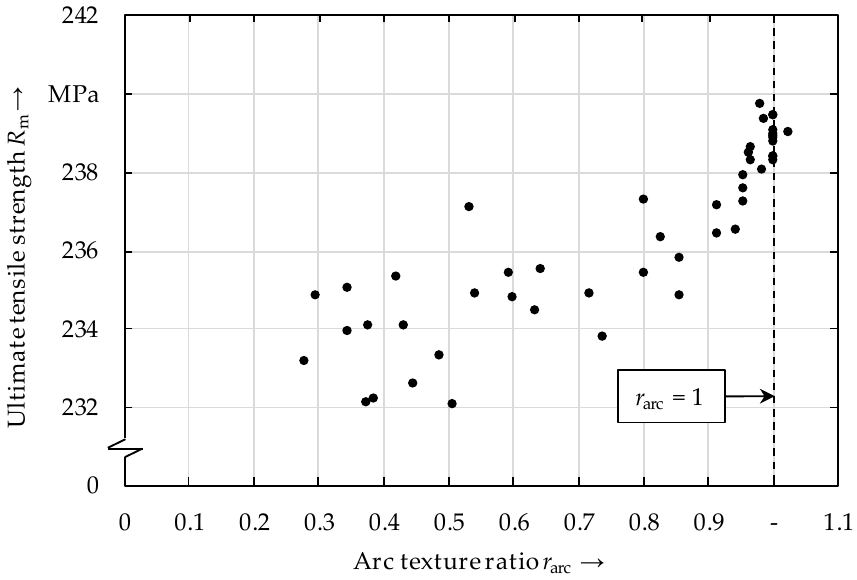
Figure 6. Ultimate tensile strength R m as a function of the arc texture ratio r arc at a welding speed v s of 500 mm/min.